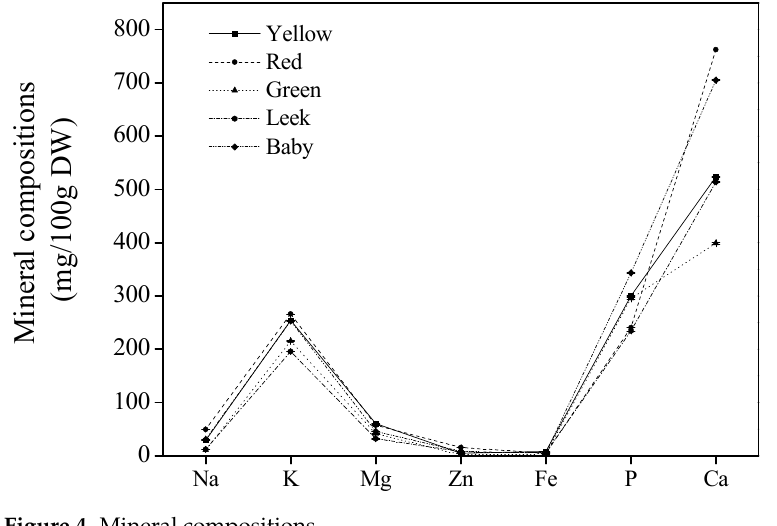
Figure 4. Mineral Figure 4. Mineral compositions.